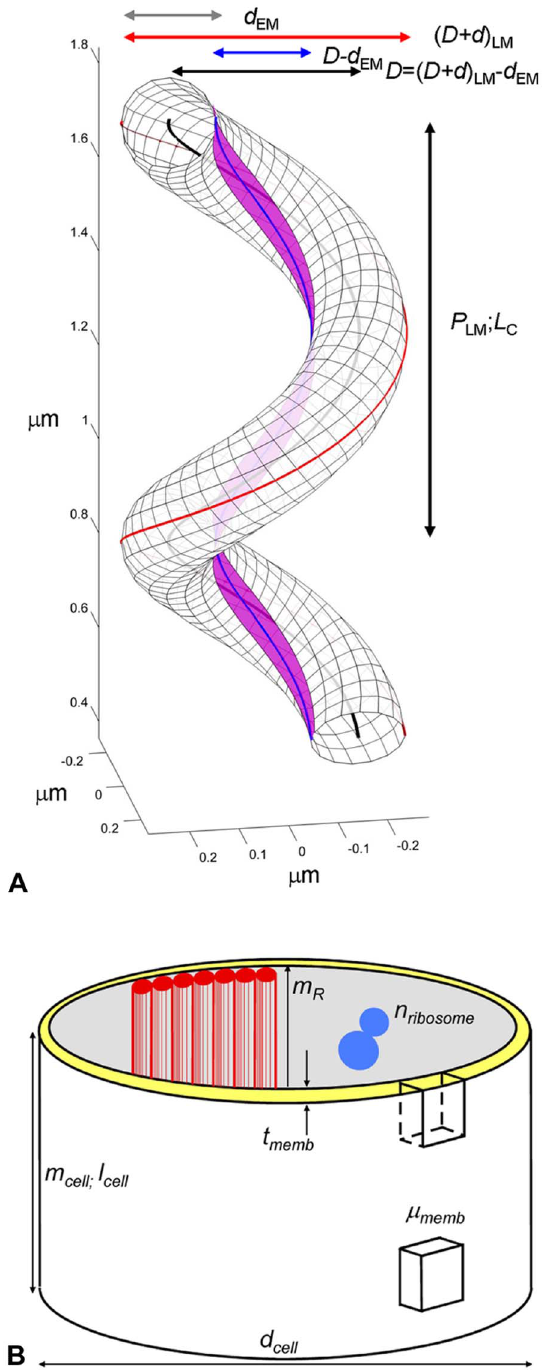
Figure 1. Cell geometry and measurble parameters. [A] Schematic diagram showing a right-handed, 1.5 turn helical tube with dimensions similar to an average Spiroplasma cell. LM and EM subscripts indicate parameters measured directly by light- and electron microscopy, respectively. one helical repeat ( P ; vertical black arrow) and corresponding helical centerline, L C – black line, are marked. The basic tube diameter ( d; grey horizontal arrow), tube centerline diameter ( D; black horizontal arrow), shortest line, L S –blue line–and corresponding inner tube diameter ( D-d; blue arrow) and outer coiled-tube diameter ( D + d; red arrow) are labeled. The center of the cytoskeletal ribbon, L R , (magenta) follows the geometrically shortest helical line (blue). See Eqs. 2, 17 and 18 for analytical details [14] and Table 1 for